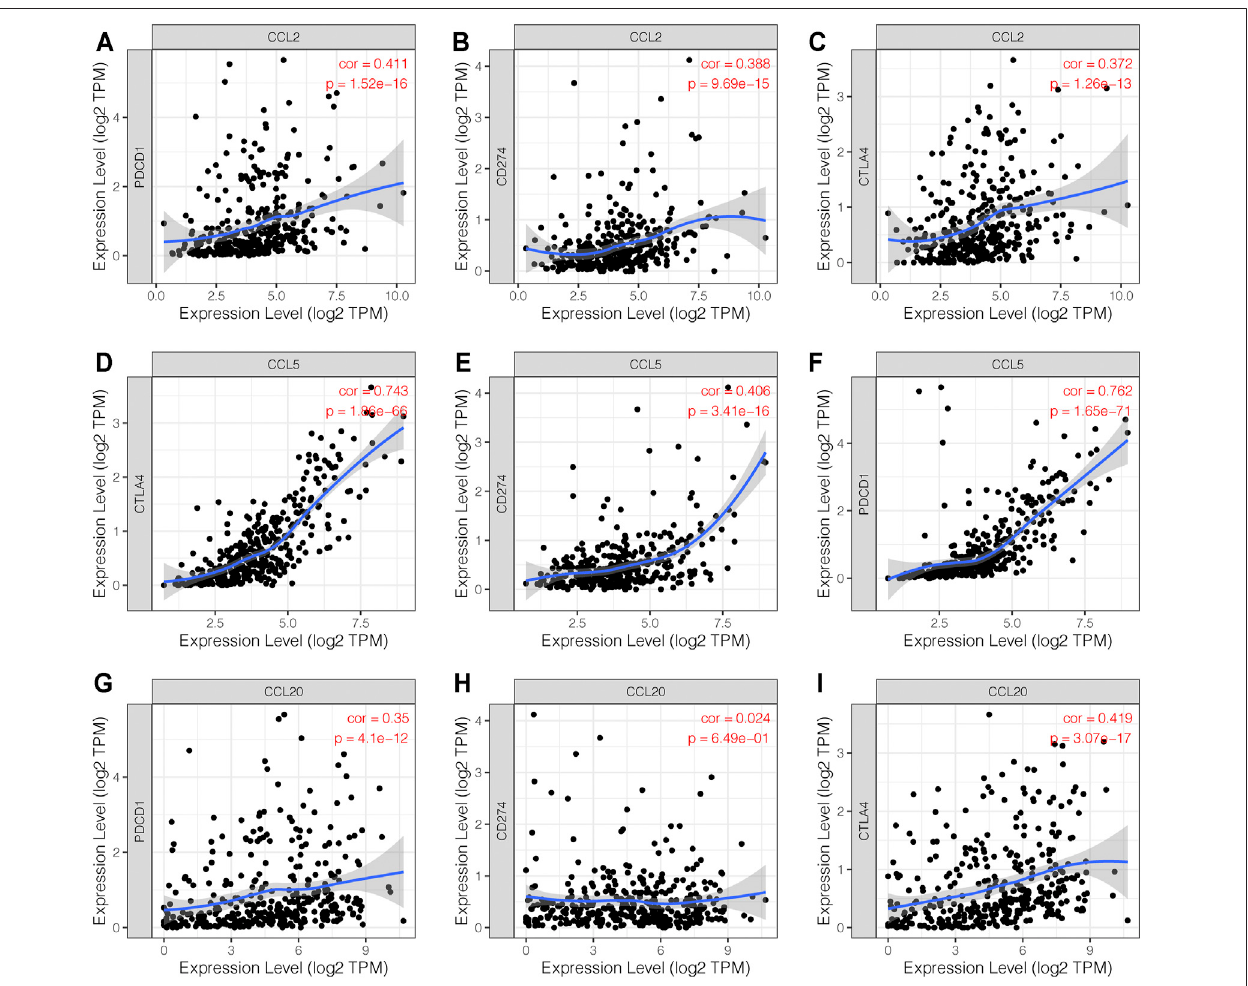
FIGURE 6 | The correlation between chemokines CCL and immune checkpoints (TIMER). (A – F) The expression levels of CCL2 and CCL5 were positively associated with PD-1, PD-L1, and CTLA-4. (G – I) The expression level of CCL20 was positively associated with PD-1 and CTLA-4.